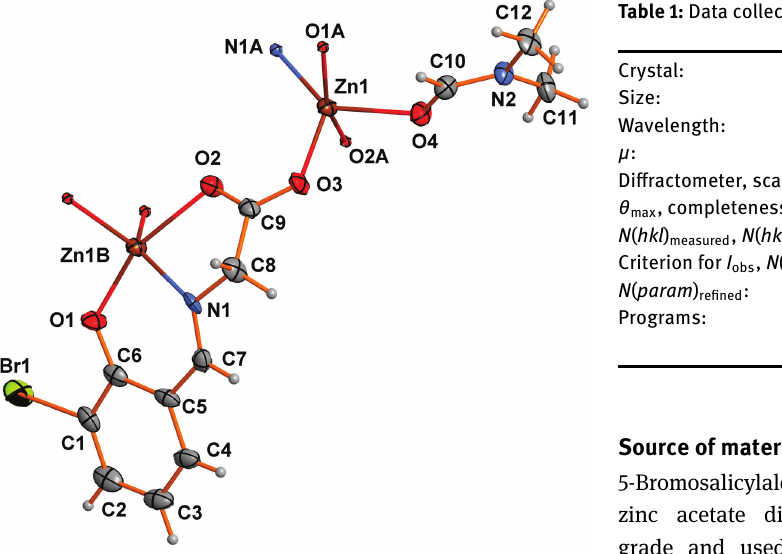
Apartofthemolecularstructureisshowninthefigure.Table1 contains crystallographic data and Table 2 contains the list of the atoms including atomic coordinates and displacement parameters.